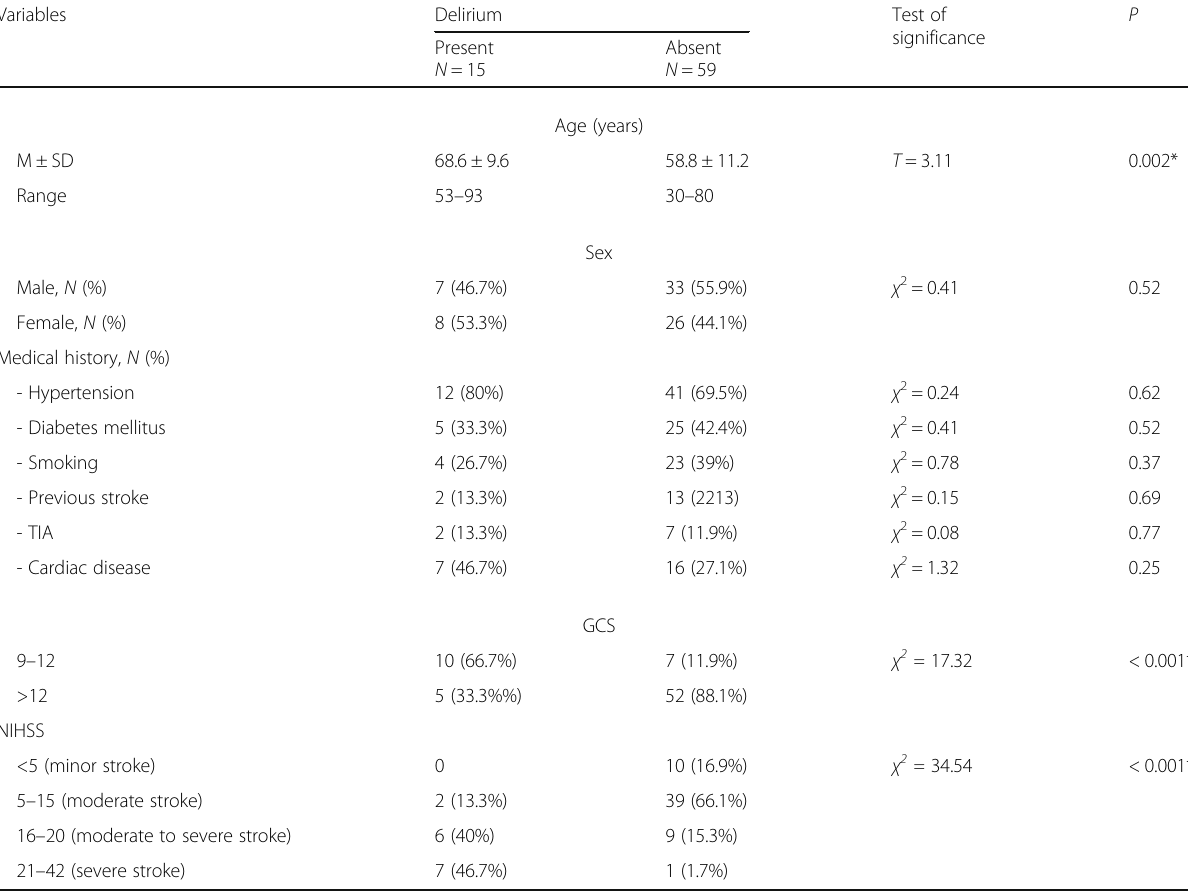
Table 2 Delirium frequency according to demographic data, medical history, and clinical examination of stroke patients Variables Delirium